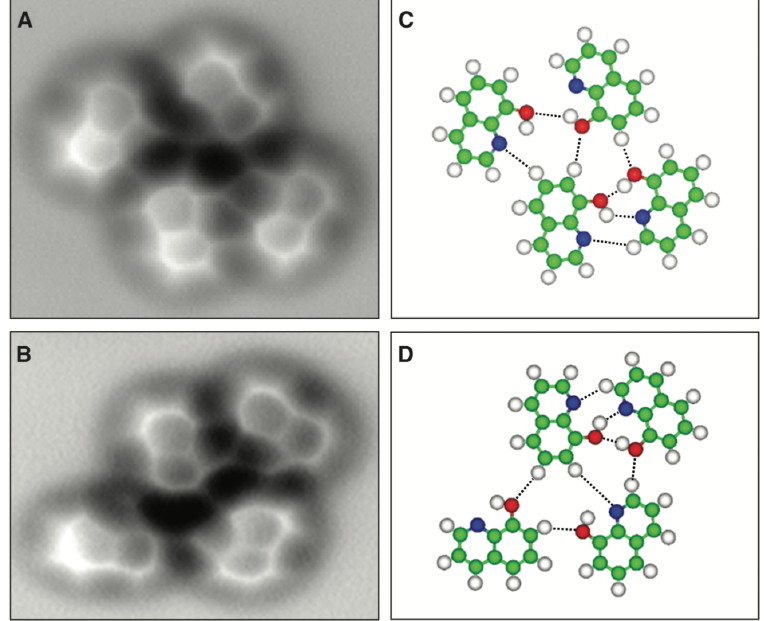
Figure 14. AFM measurements of 8-hydroxyquinoline (hq) molecules assembled clusters on Cu(111). ( A , B ) Constant-height frequency shift images of typical molecule-assembled clusters and their corresponding structure models ( C , D ). Imaging parameters: V = 0V, A = 100pm, ∆ z = + 10pm. Image size: ( A ) 2.3 by 2.0 nm; ( B ) 2.5 by 1.8 nm. The dashed lines in ( C , D ) indicate likely H bonds between 8-hq molecules. Green, carbon; blue, nitrogen; red, oxygen; white, hydrogen. Adapted with permission from American Association for the Advancement of Science from Figure 2 in [75].